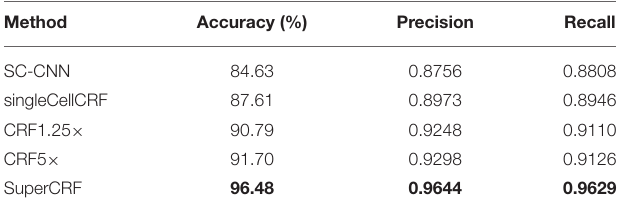
TABLE 2 | Evaluation of different conditional random fields (CRF) versions and a state-of-the-art spatially constrained-convolution neural network (SC-CNN) deep learning